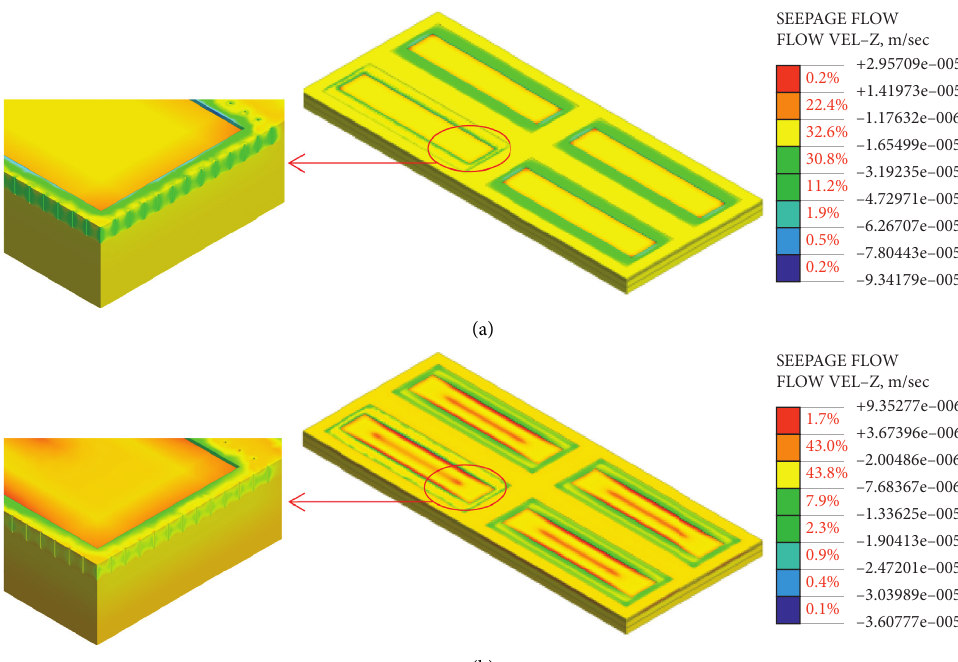
Figure 25: Infiltration velocity nephograms of buildings with seepage wells placed around building 1 after (a) 10 min and (b) 120min of rainfall in the numerical model (the color of the legend represents the infiltration velocity range. The value of the legend represents the infiltration velocity value. The red % represents the volume percentage of color legend in the whole numerical